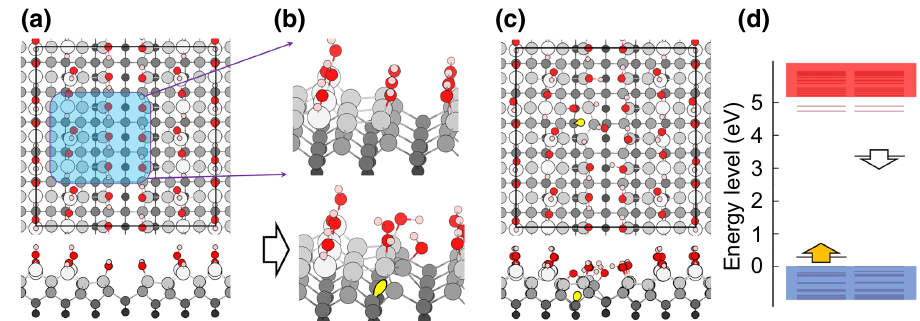
FIG. 8. Surface spin model. (a) The trench structure of a (100)-6 × 6 diamond surface. Surface termination is O/H/OH type, as in Ref. [34], and step carbon atoms are saturated by OH. The red and pink balls are hydrogen and oxygen atoms, respectively. The gray balls are carbon atoms, with the darker color and smaller size indicating deeper positions away from the surface. For the sake of clarity, only the first five layers are presented in the structure plots. (b) Illustration of the formation of a surface spin at the step edge. The yellow lobe represents the surface spin. (c) A plausible structure model of a surface spin on the trench of the diamond (100) surface. (d) The energy-level plot of the modeled surface spin. The valence and conduction bands are depicted as blue and red regions, respectively. The orange and white arrows represent spin-up and spin-down channels, respectively. The spin-polarization energy is high for the dangling bond. We note that the single-particle Kohn-Sham levels do not directly refer to the ionization energies of the dangling bond. The surface states are located at 0.3 eV below the conduction band minimum. The valence band maximum positions are aligned to